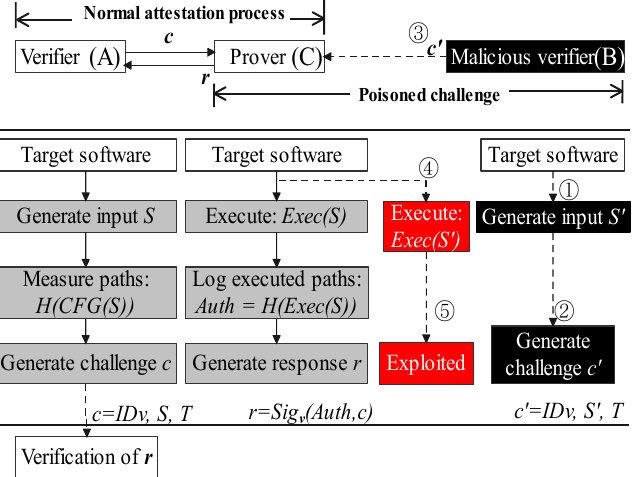
Figure 1. The execution of a poisoned challenge may enable the hijacking of a prover’s